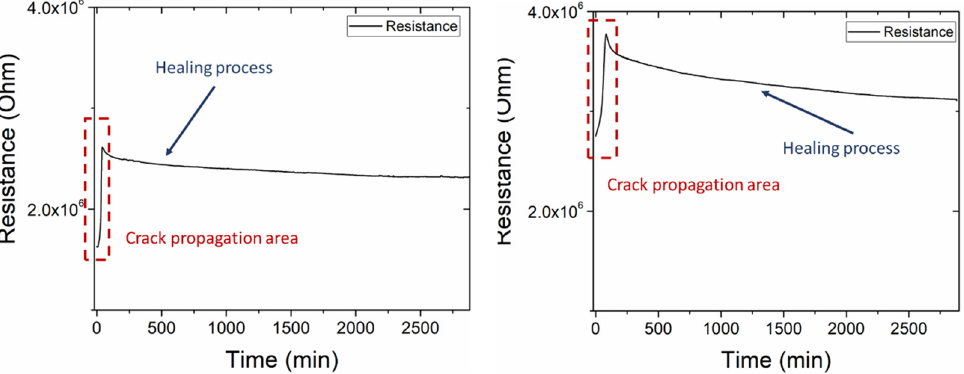
Figure 9. Online monitoring of resistance during the experimental procedure (damage and self- healing) of mode-II specimens containing neat ( left ) capsules and with a nano-enhanced healing agent ( right